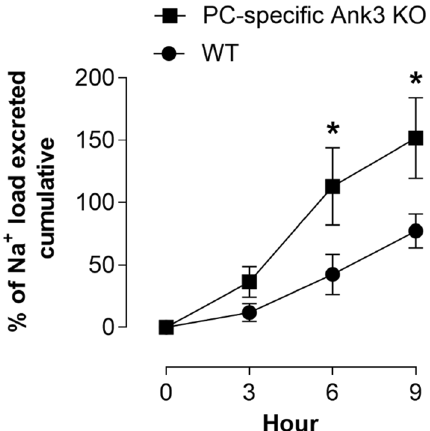
Figure 5. PC-specific Ank-3 KO mice excrete a sodium load faster. Summary graph showing cumulative Na + excretion as a function of time (measured every 3 h) in WT mice (black circles, where n = 4 independent trials) and PC-specific Ank-3 KO mice (black squares, where n = 4 independent trials) injected (i.p.) with a Na + load (100 µL, 0.9% NaCl solution). Load introduced at time 0. Cumulative Na + excretion was significant greater *P < 0.05 vs. WT